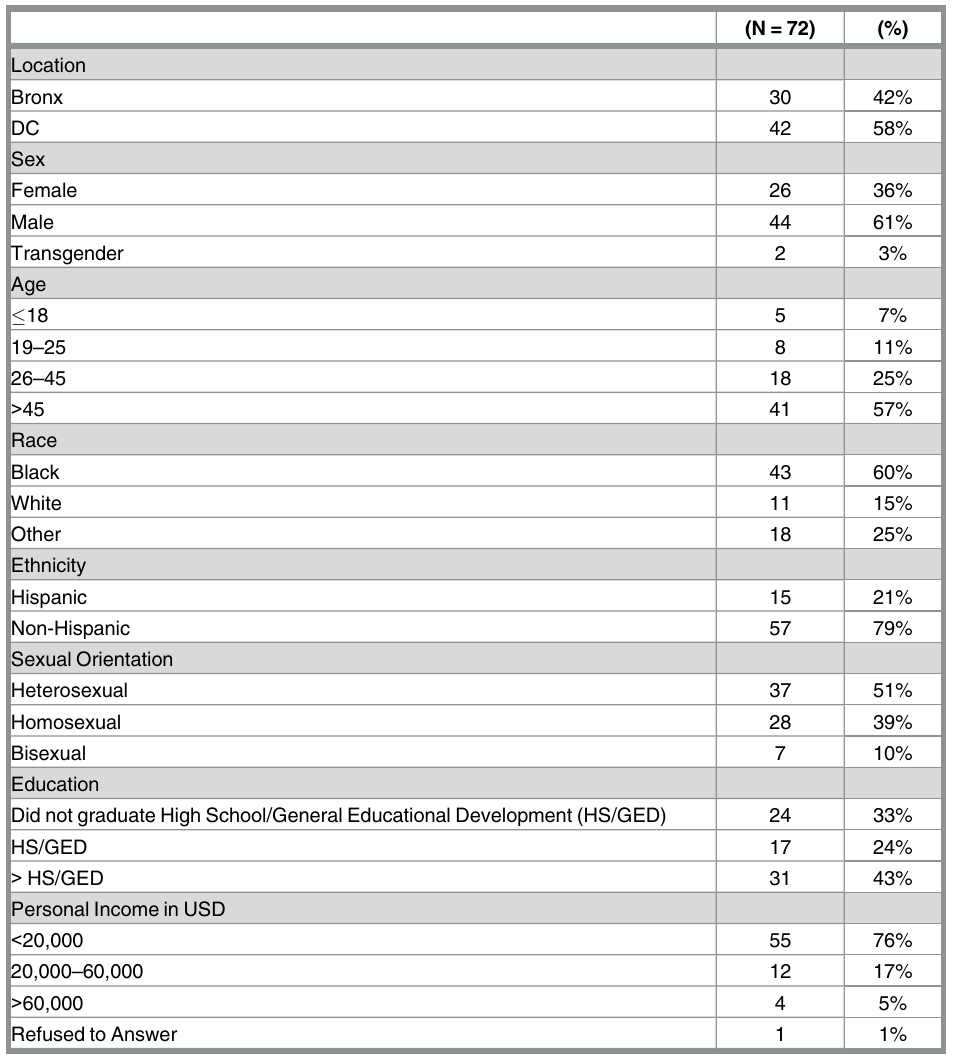
Table 3. Patient